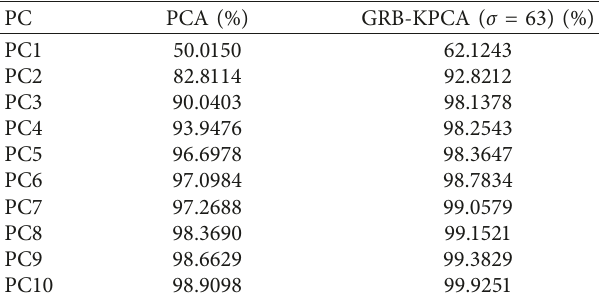
Table 3: Cumulative contribution rates of the first ten PCs of continuum-removed spectra of the 150 training samples in the eight selected wavelength range in Table